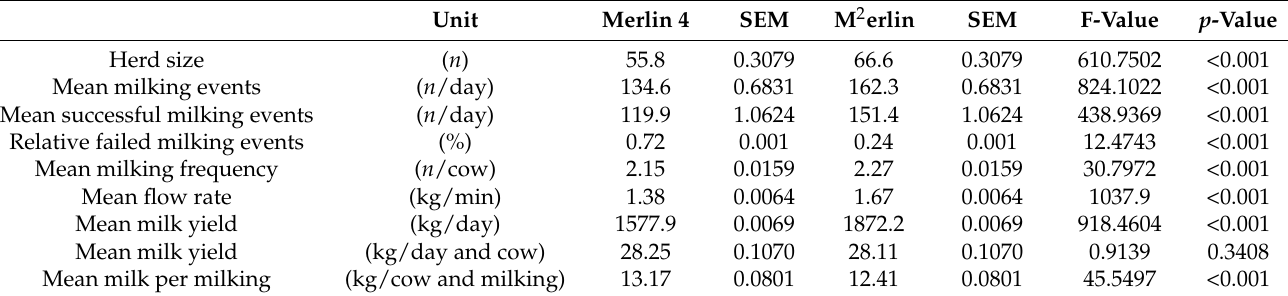
Table 2. Differences in the milk production in dependency of the AMS.